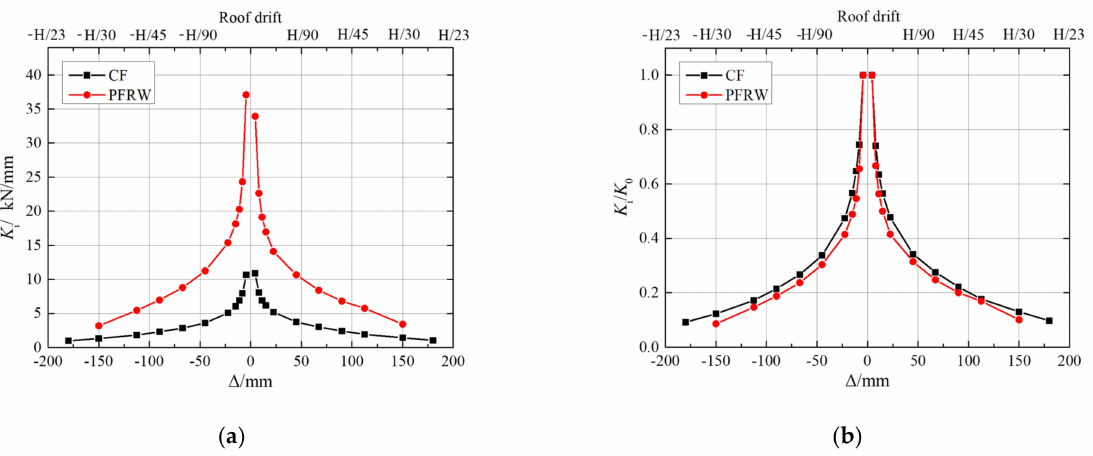
Figure 10. Stiffness degradation of frames. ( a ) evolution of secant stiffness of each frame, K i ; ( b ) stiffness degradation normalized by K 0 for each